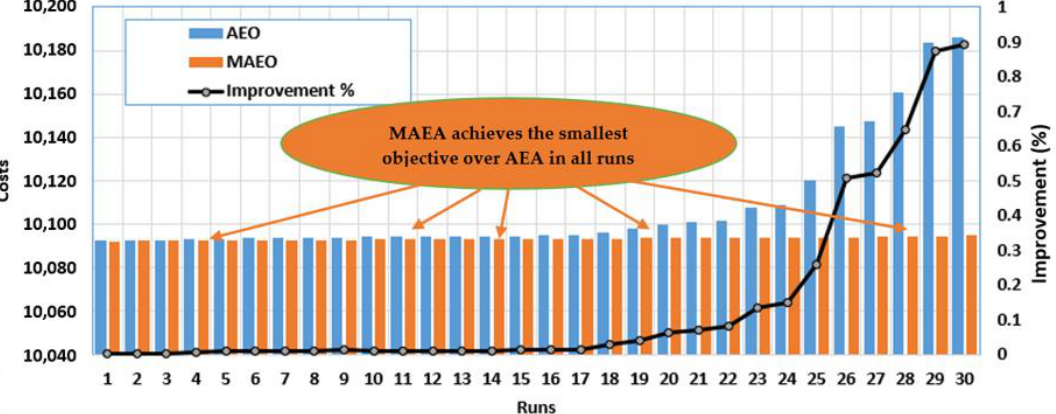
Figure 4. Obtained costs for all simulated runs of the proposed MAEA and the basic AEA of Case 1. Based on that outcome in Figure 4, Table 2 records the robustness metrics of the pro- posed MAEA and the basic AEA of Case 1 in terms of the minimum, mean, maximum, and standard deviation. As shown, superior resilience performance related to the pro- posed MAEA is declared over the basic AEA. The proposed MAEA acquires the lowest minimum, mean, maximum, and standard deviation of 10,092.18, 10,093.32, 10,095.17, and 0.734646 USD/h, with improvements of 0.0023, 0.145, 0.892, and 97.31%, respectively. Table 2. Robustness metrics of the proposed MAEA and the basic AEA of Case 1. Costs (USD/h) AEO Proposed MAEA Improvement % Minimum 10,092.41 10,092.18 Maximum